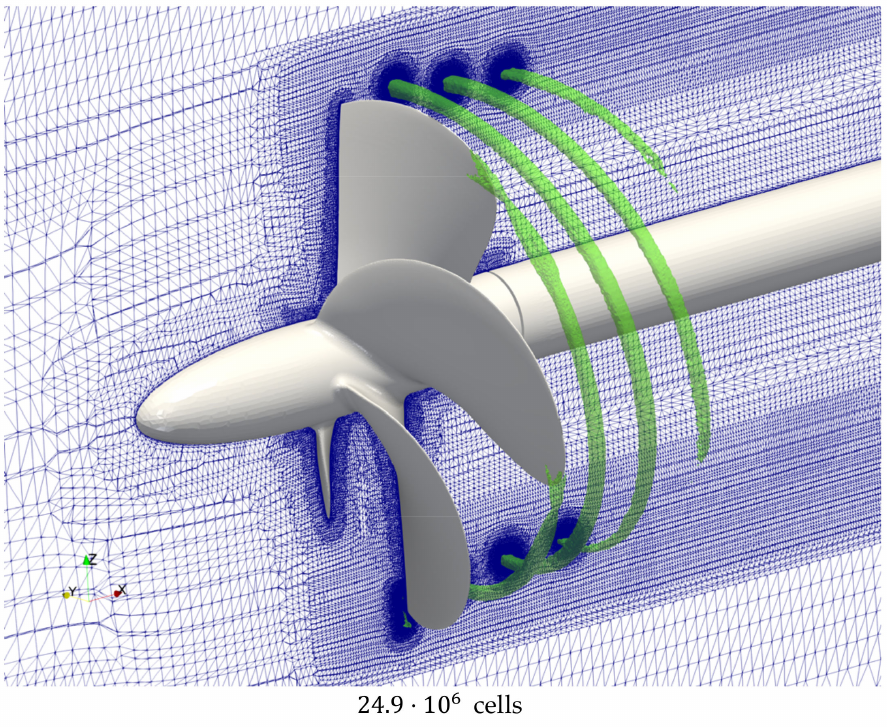
Figure 2. Newcastle. Distance refinement in tip vortex region based on Q -criterion Q = 5 · 10 5 s − 2 for condition